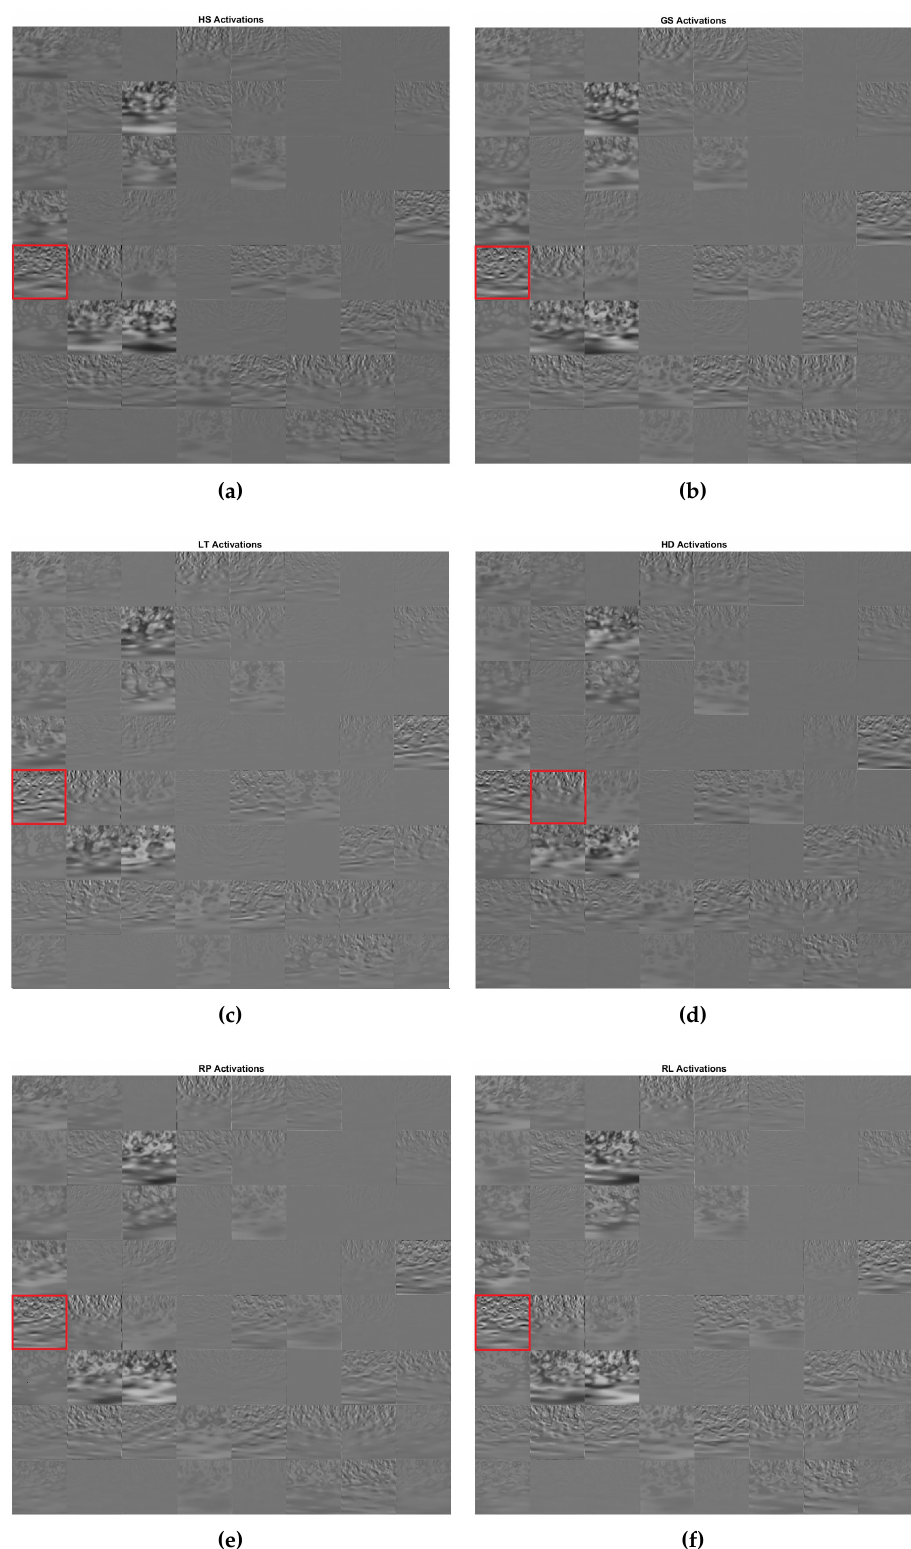
Figure 9. Output activation of the GoogLeNet first convolutional layer, conv 1 − 7 × 7 for six motor events, ( a ) HS, ( b ) GS, ( c ) LT, ( d ) HD, ( e ) RP, and ( f ) RL tested in the framework of one-versus-rest. The square red box indicates the filter with the strongest